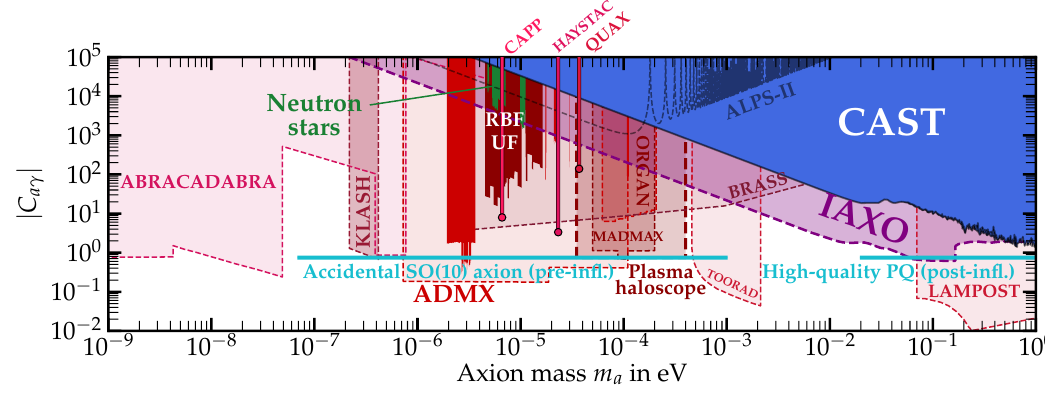
Figure 1 . Axion-photon coupling (eq. (A.26) with E=N = 8 = 3) and sensitivity of present (full lines) and future (dashed lines) axion experiments. The accidental SO(10) axion mass window (in the pre-in(cid:13)ationary PQ breaking scenario) corresponds to m a PQ symmetry is obtained for m a & 0 : 02 eV (in the post-in(cid:13)ationary PQ breaking scenario). Axion limits from